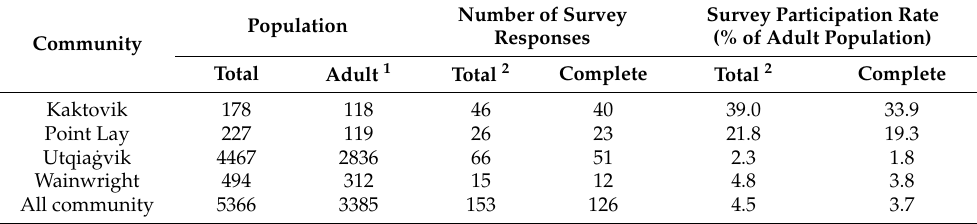
Table 2. Number of